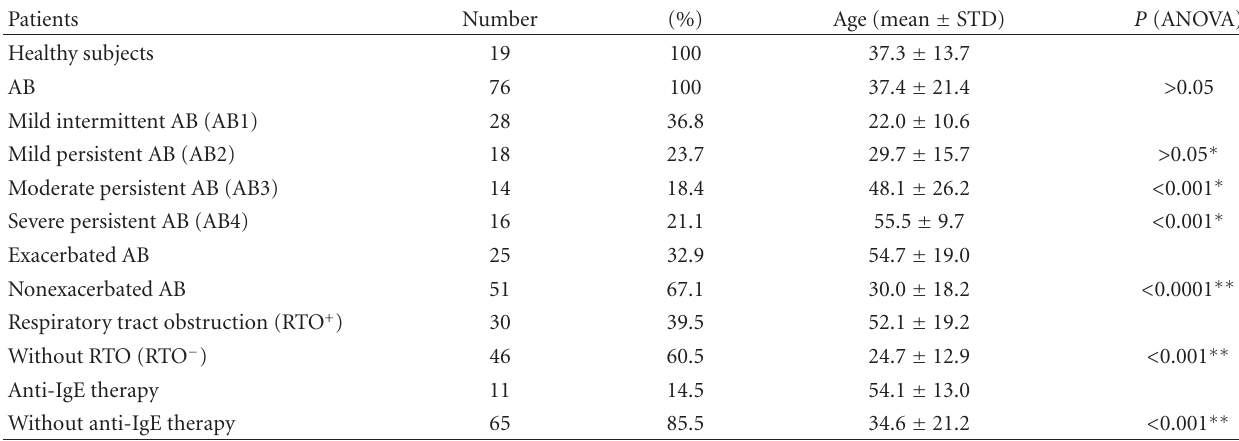
Table 1: Characteristics of investigated asthma bronchiale patients.